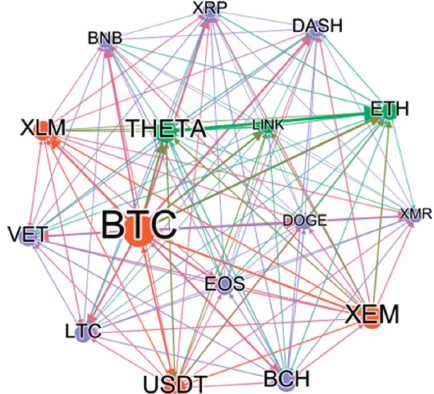
Figure 34: Risk spillover under E1.